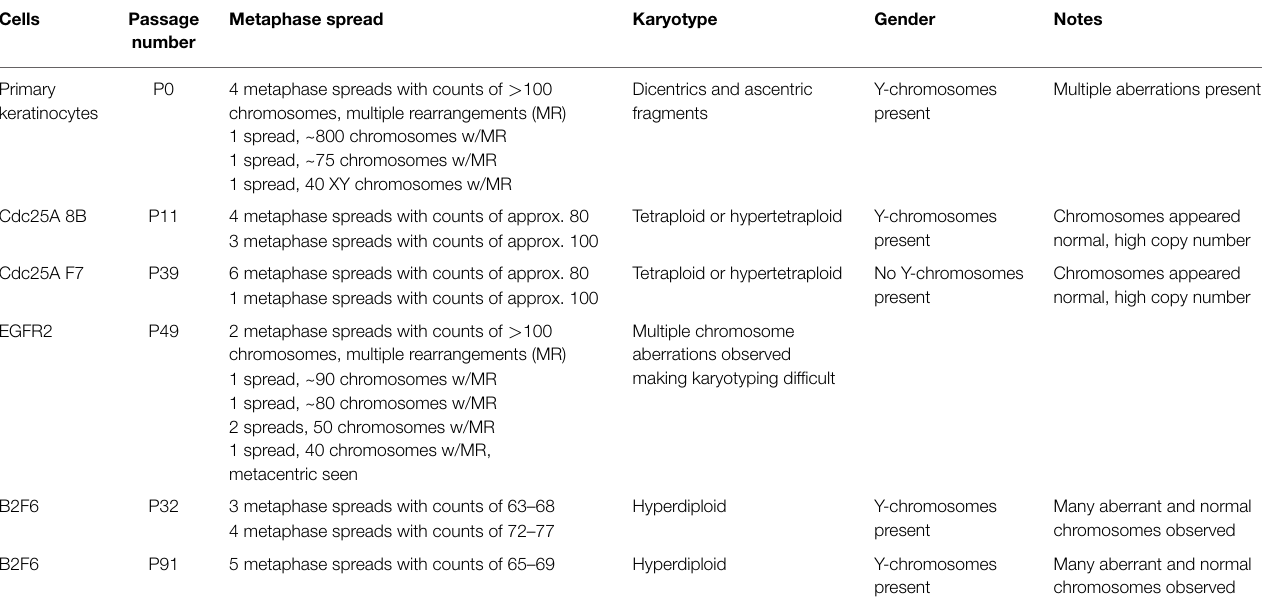
TABLE 2 | Karyotypes of immortalized and primary keratinocyte cultures